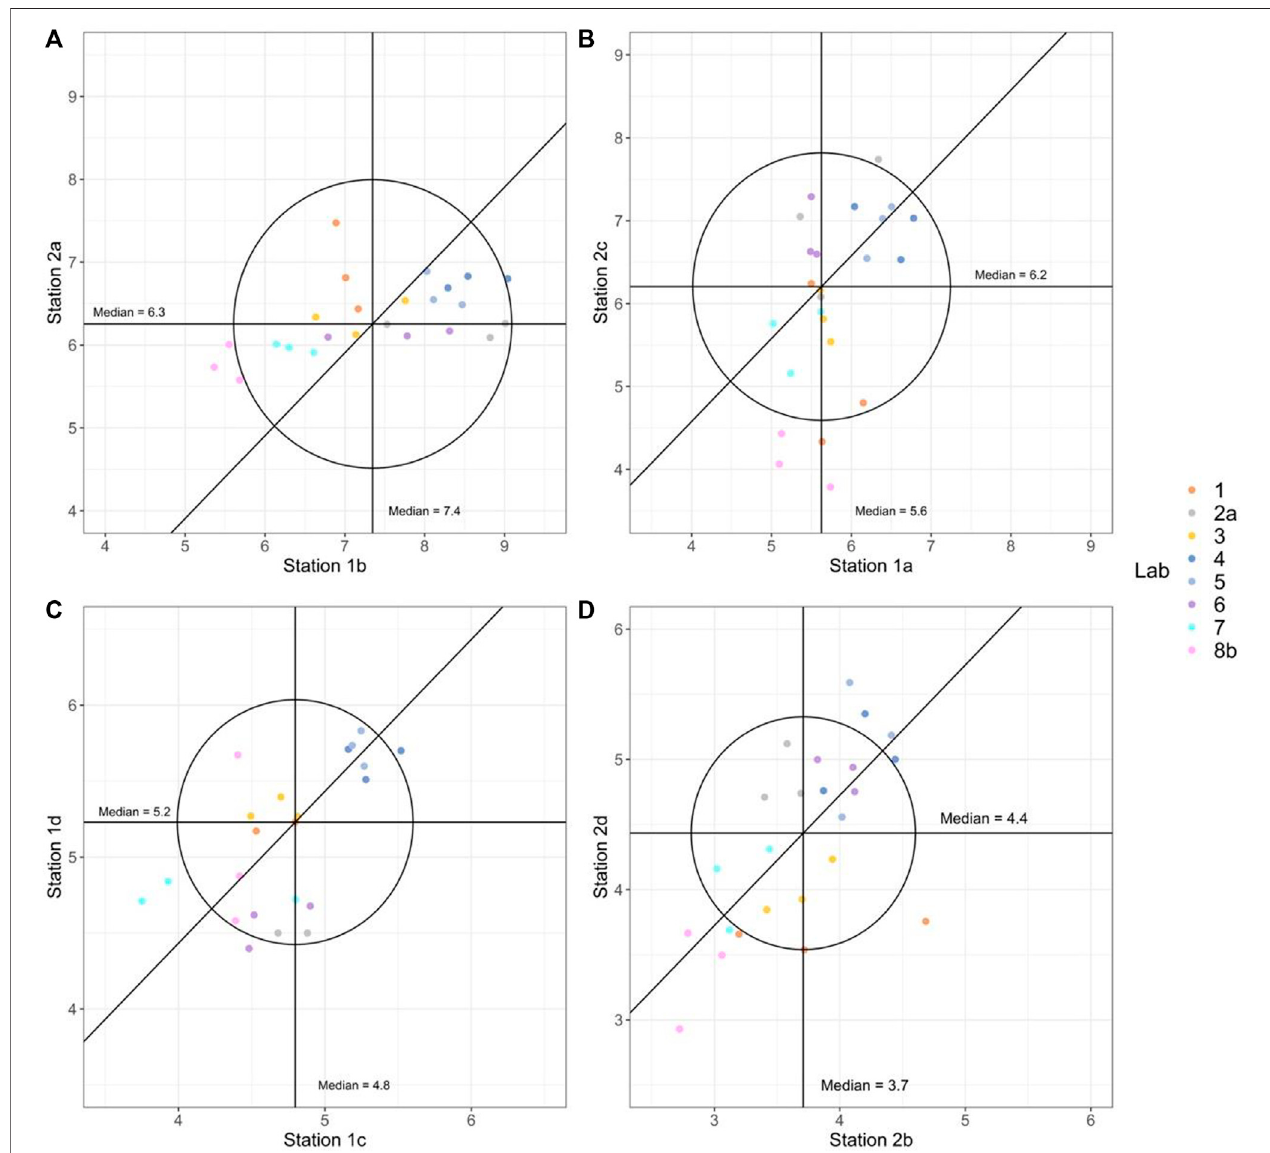
FIGURE4| Youdenplotsofpairedstationsofsimilarconcentrations.Thehorizontallinerepresentsthemedianvalues(indicatedintheplots)ofallsamplesfromthe station on the x -axis and the vertical line represents the median values (indicated in the plots) of all samples from the station on the y -axis. A 45 ° reference line is drawn based on thetwomedian values. The distance from thereferenceline indicates theproportion ofrandom errorsand thedistancefrom themedian centroid indicates the proportion of systematic errors. The circle indicates which observations fall within the 95% con fi dence interval with no bias or else outside.